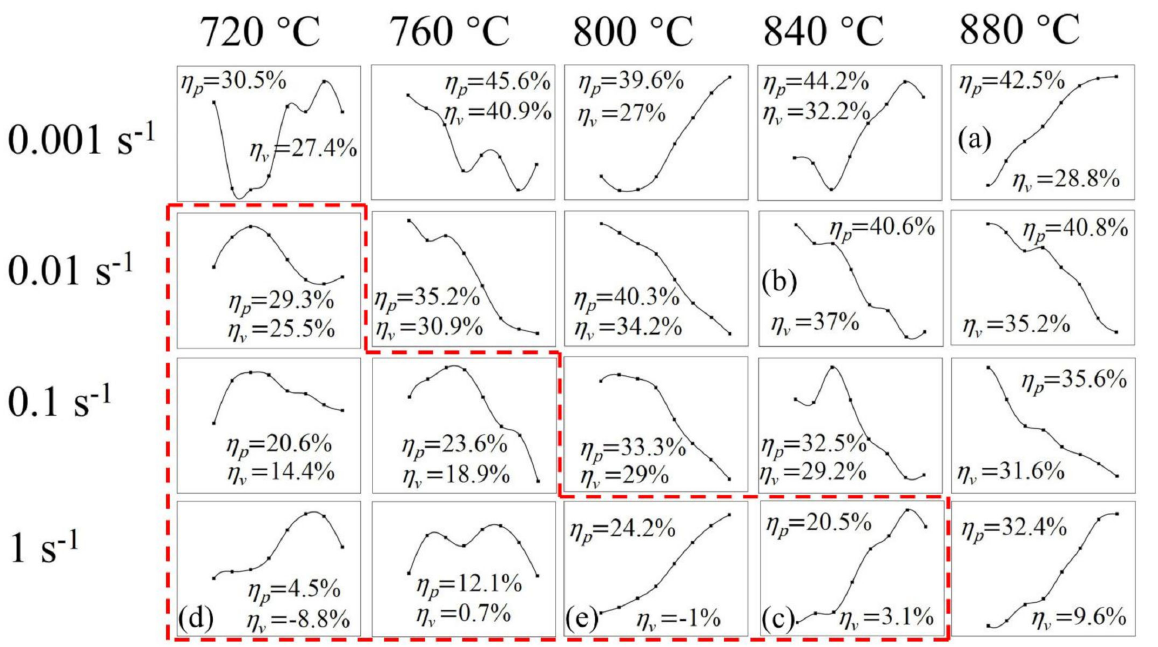
Figure 9. Change rules of η with the true strain under different deformation